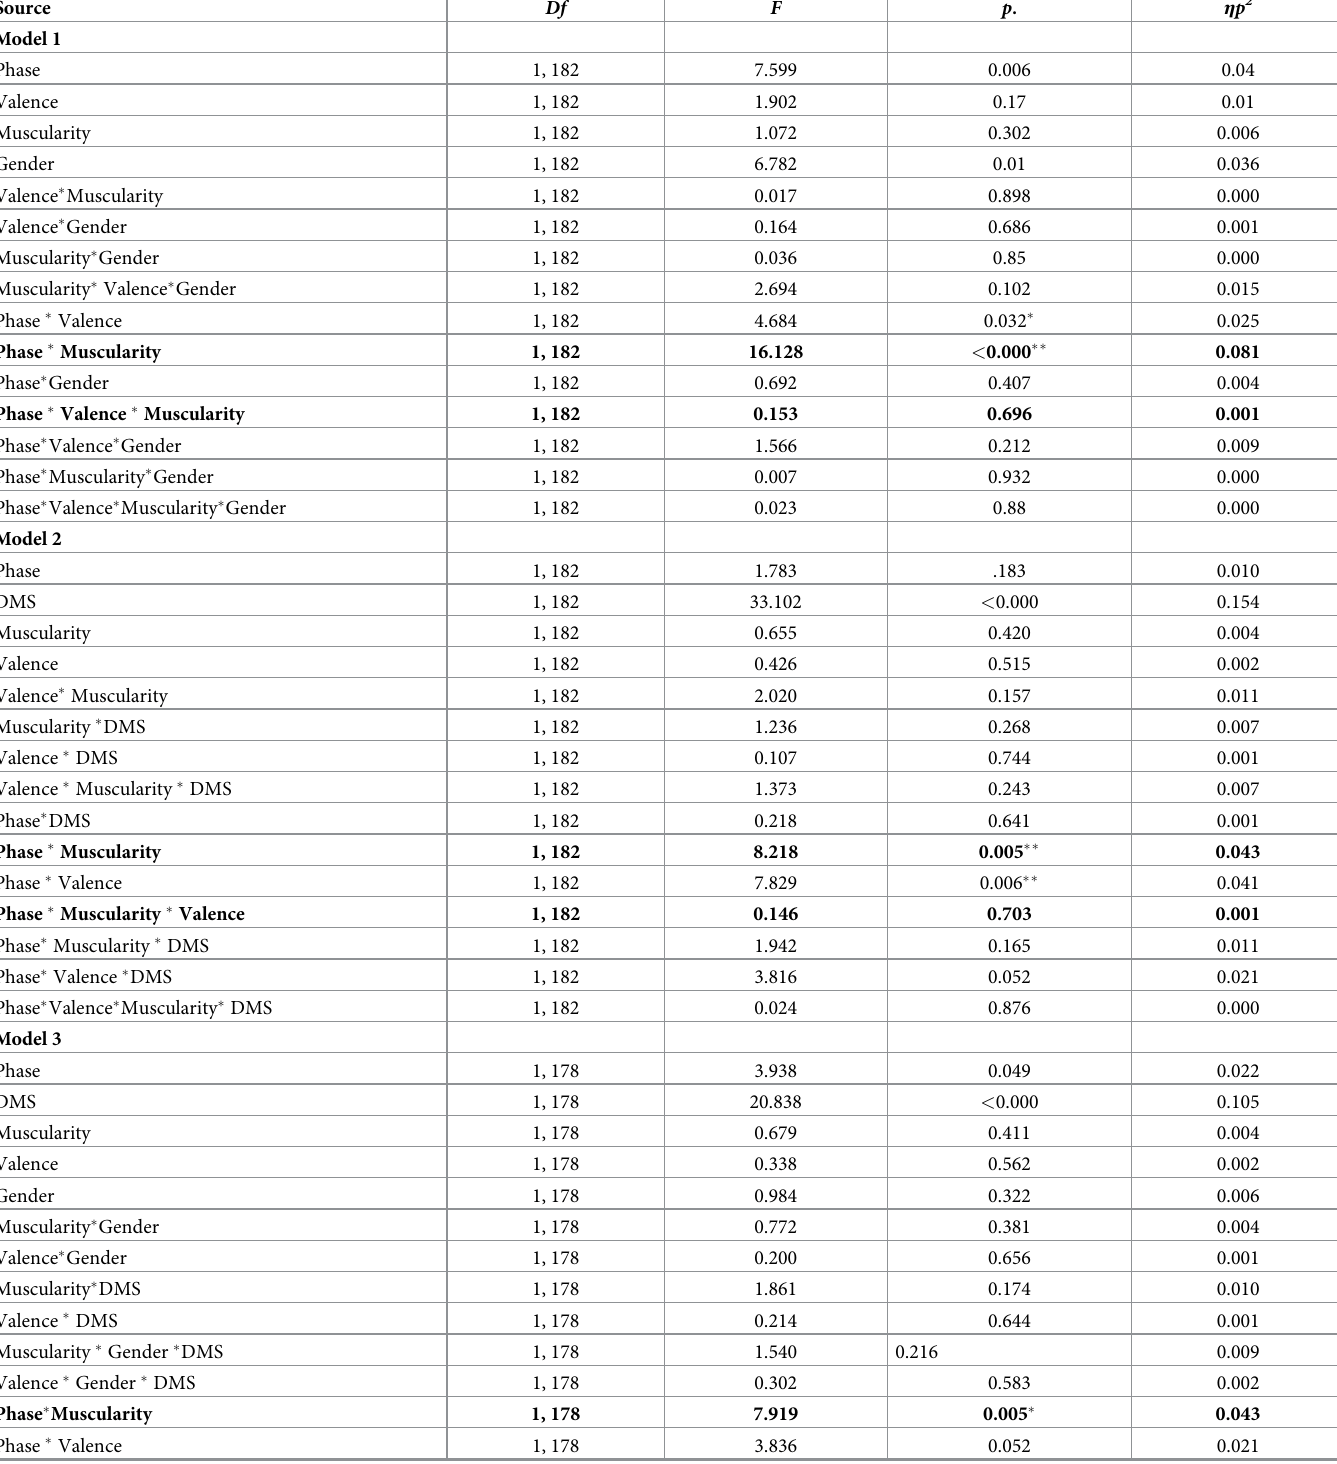
Table 3. Tabulated values for mixed ANOVA with phase (pre- versus post-manipulation preference for muscularity scores) as the repeated measures variable, and model muscularity (high muscle mass or low muscle mass), model valence (aspirational or neutral) and participant gender (Model 1) as between-participant